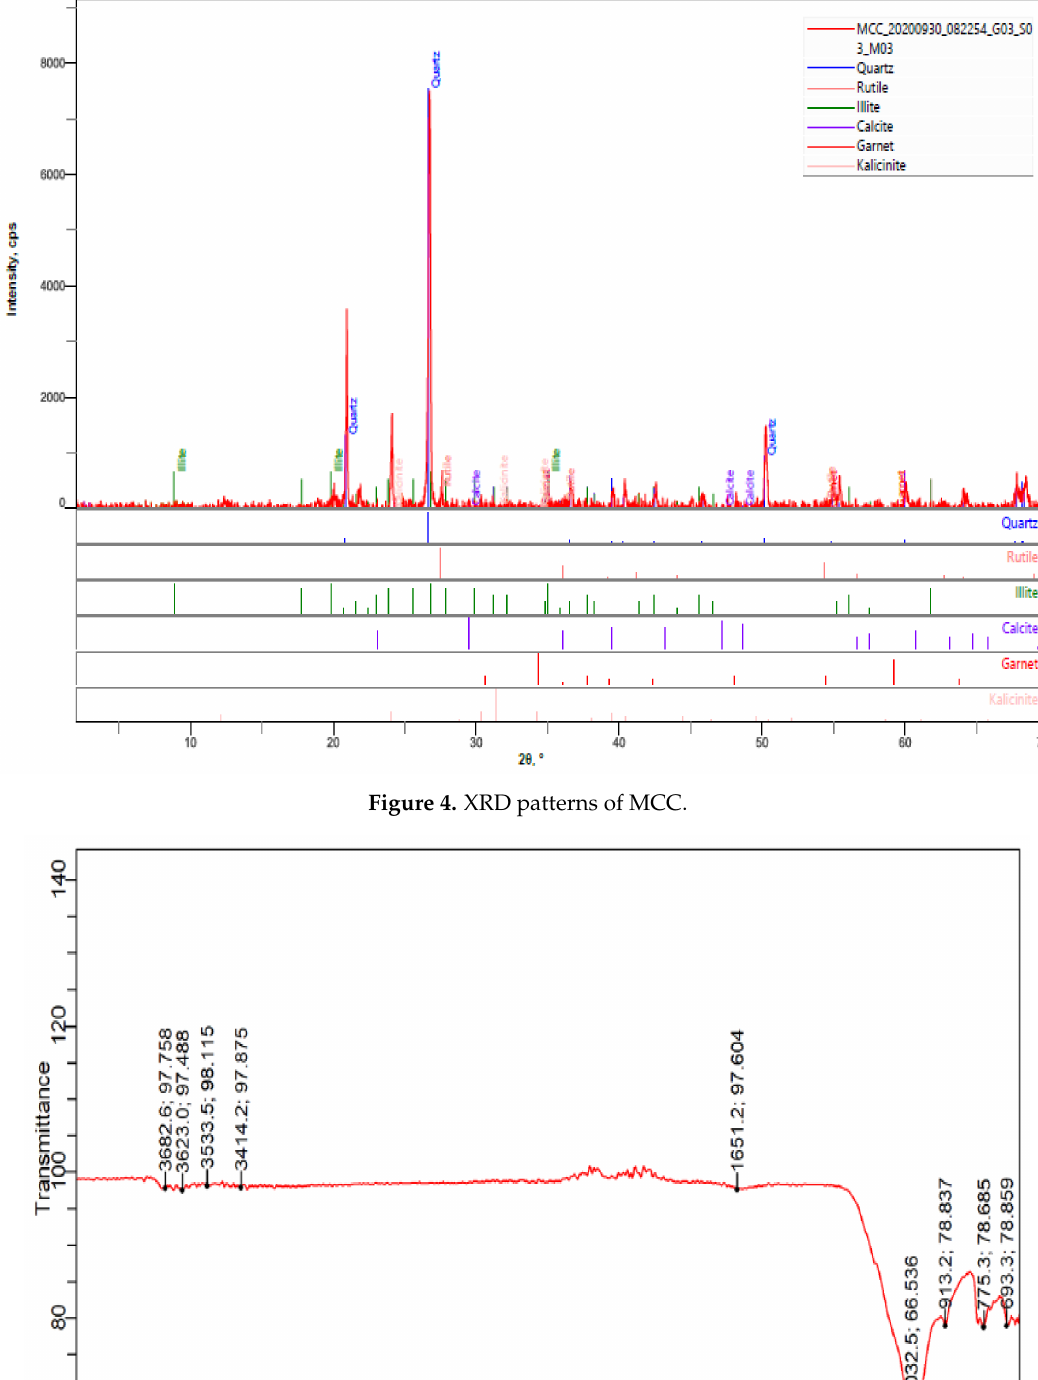
Figure 5. FTIR/ATR patterns of